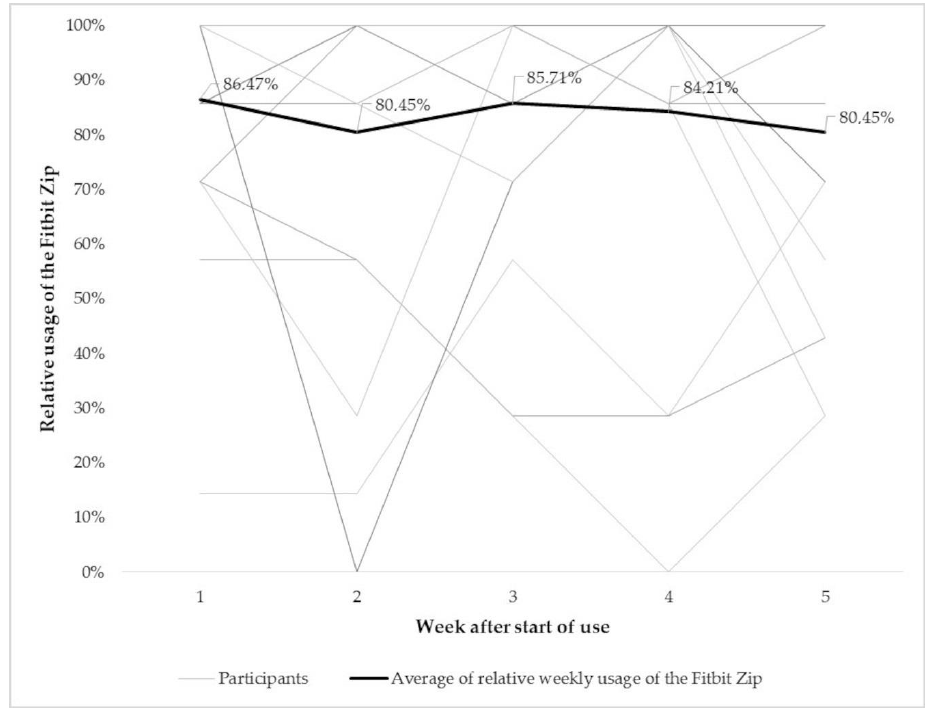
Figure 5. Average of the relative weekly usage of the Fitbit Zip over the period of the first five weeks of wearing ( n = 19).